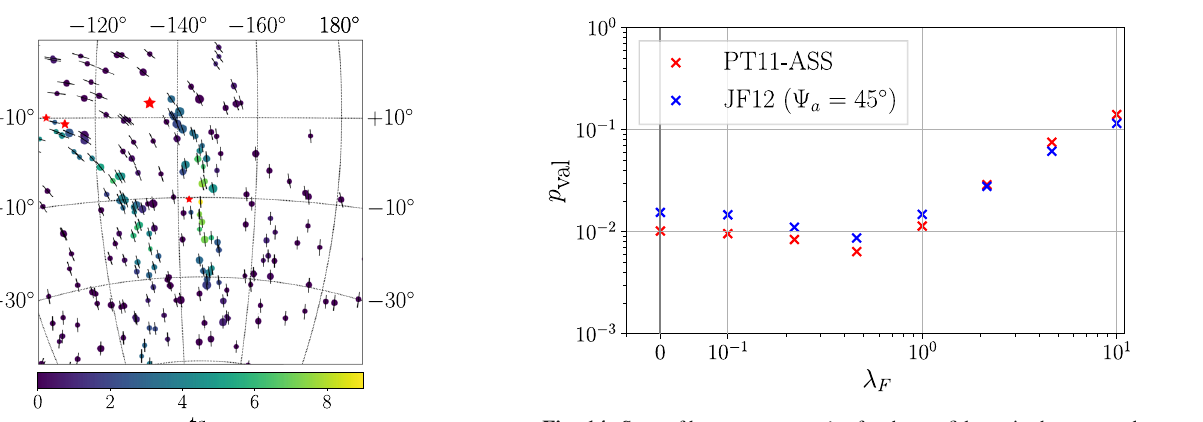
Fig. 14 Scan of hyperparameter λ F for the confidence in the assumed GMF model (here JF12). The initializationof the tangent vectorfield ˆ u 0 follows the JF12 GMF procedure and the isotropic chance probability p val is derived for the benchmark 2 simulation with a source density of ρ = 3 × 10 − 2 Mpc − 3 from Sect. 3. The red crosses show deflections in S the PT11-ASS model and the blue crosses show deflections in the JF12 model,whichismodifiedbyadipolarmodulateduncertaintyanglewith amplitude Ψ